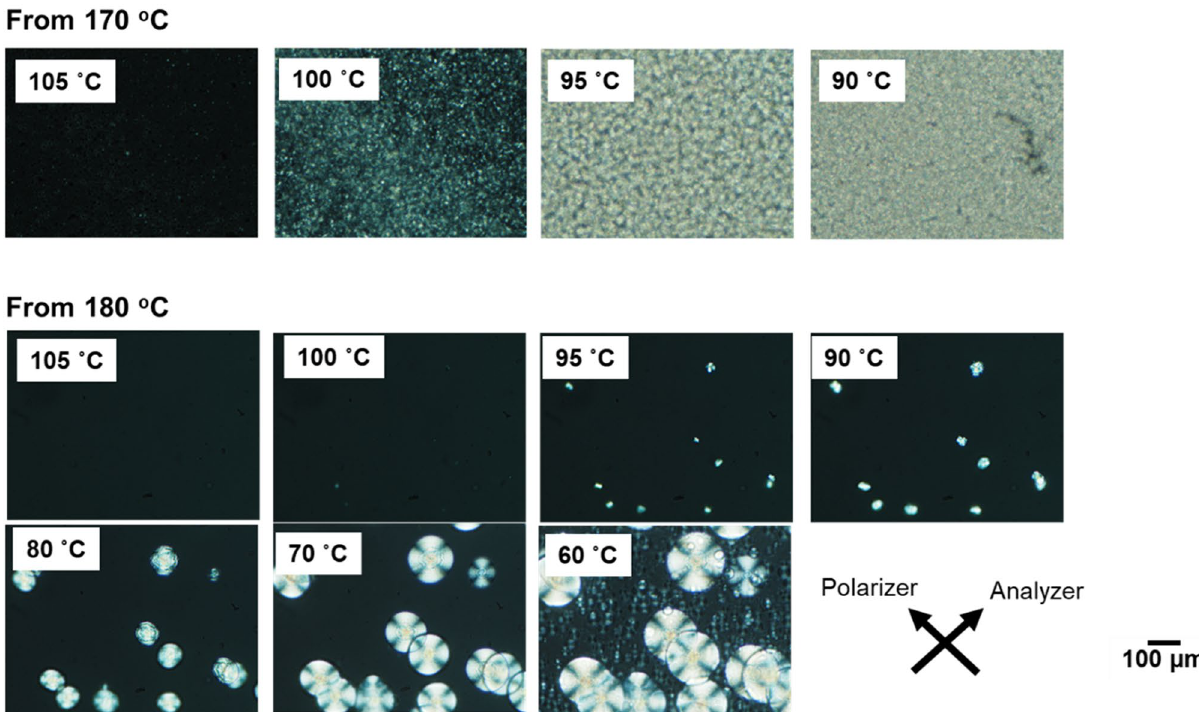
Figure 5. Polarizing optical microscope (POM) images obtained using crossed polars that indicate the morphology of the samples during cooling from 170 °C (top) and 180 °C (bottom) without shear history. The cooling rate was 10 °C min −1 .